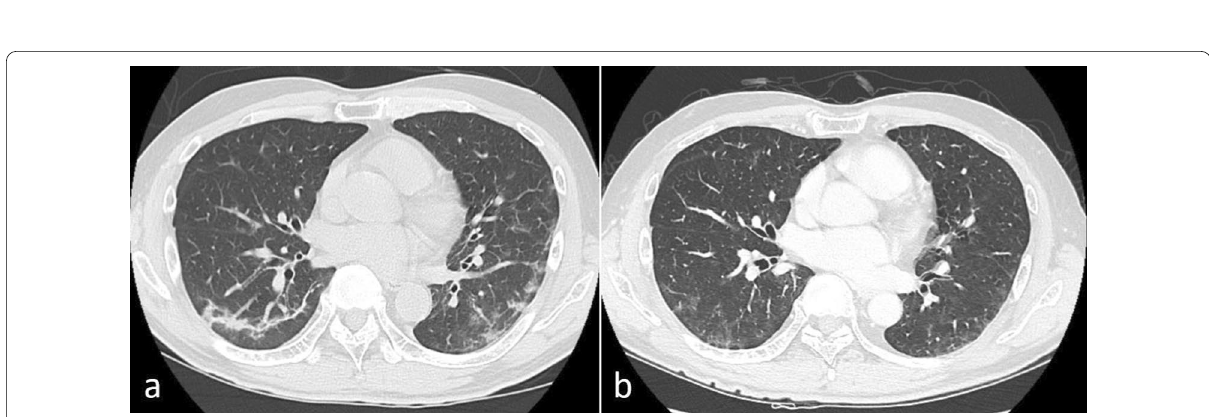
Fig. 4 Findings of case 2 with chest computed tomography. a A crazy-paving pattern and small ground-glass opacities were located peripherally in bilateral lower lobes immediately after COVID-19 infection. b Ground-glass opacities were still present 19 days before the